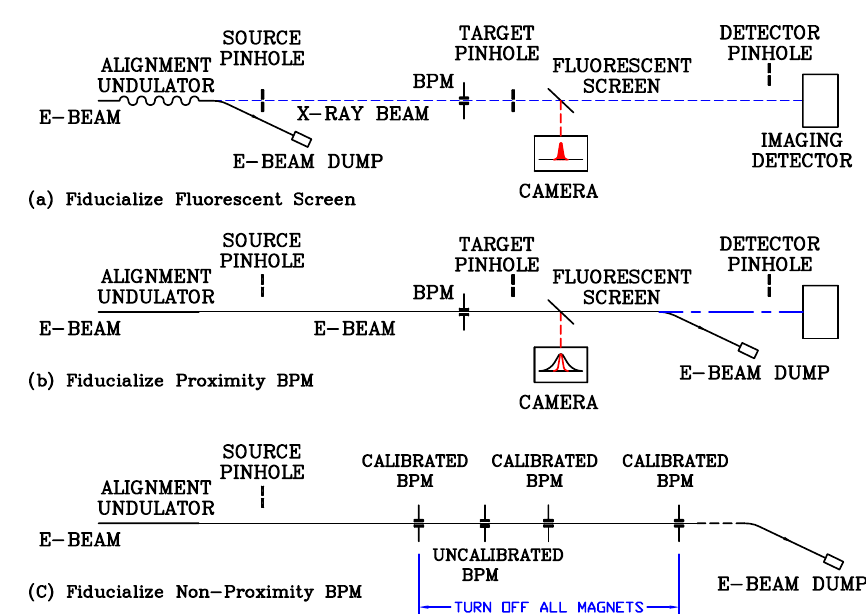
FIG. 8. (Color) Fiducialization of electron BPMs.